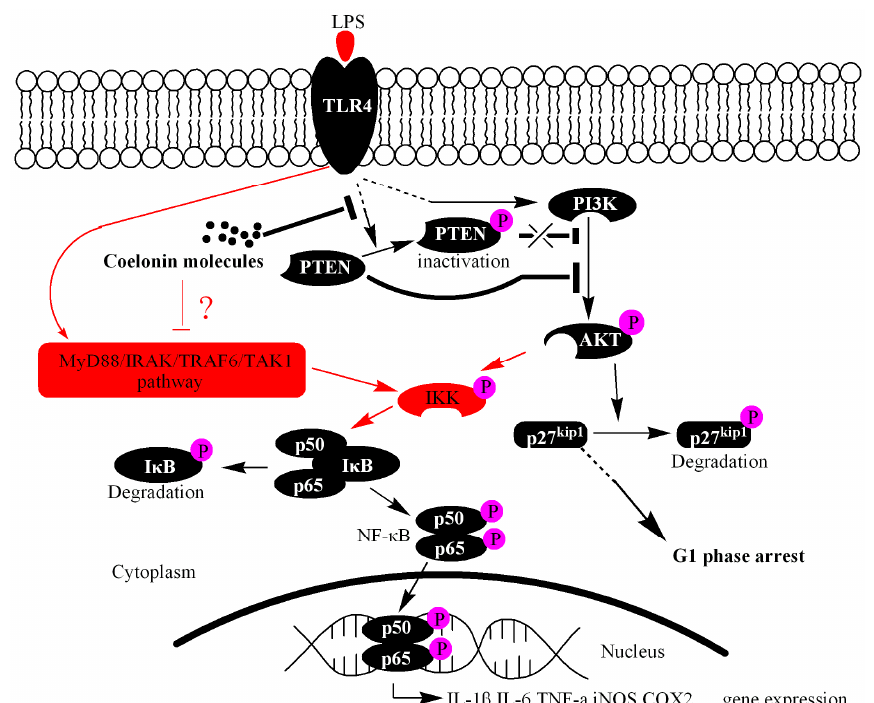
Figure 9. Proposed mechanism of coelonin inhibiting LPS-stimulated activation of NF- κ B and inducing G1 phase cell-cycle arrest in RAW264.7 cells. Coelonin inhibits the expression of inflammatory cytokines IL-1 β , IL-6 and TNF- α in RAW264.7 cells treated by LPS may partially through the PTEN / AKT pathway. However, it induces G1 cell cycle arrest of RAW264.7 cells by inhibiting the degradation of p27 Kip1 in a PTEN-dependent manner. The black arrow section has been verified, while the red arrow section needs further validation. The question mark indicated that coelonin may inactivate NF- κ B by inhibiting TLR4 / MyD88 / TRAF6 / TAK1 signal pathway, the canonical pathway of NF- κ B